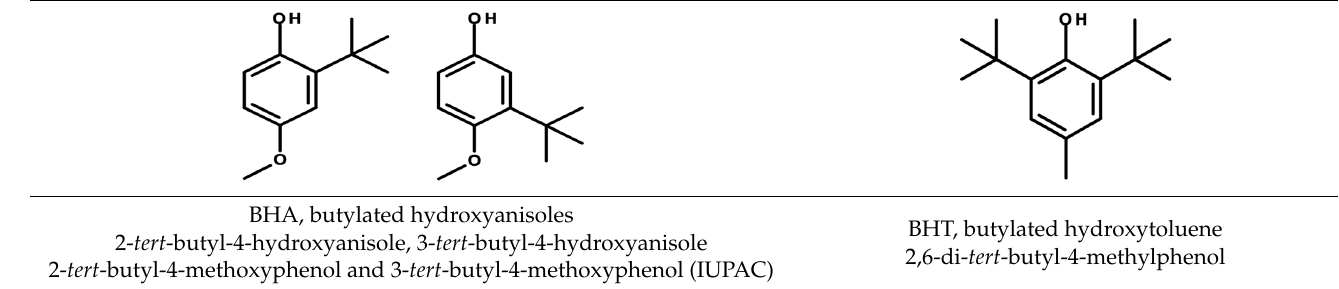
Table 6. Chemical structure of tert -butyl compounds.